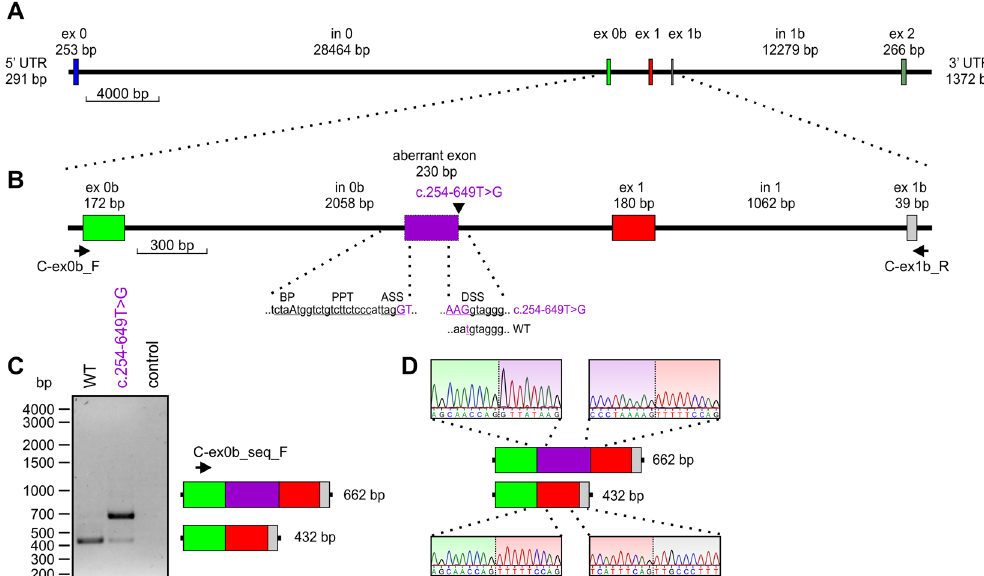
Figure 3. CLRN1 minigene splice assay. ( A ) Schematic to scale overview of the genomic CLRN1 structure including the 5 ′ and 3 ′ untranslated regions (5 ′ UTR and 3 ′ UTR, respectively). bp, basepairs. Exons (ex) are shown as colored boxes. ( B ) CLRN1 to scale minigene used for the splice experiments shown in ( C , D ). The position of the c.254–649 T > G mutation is indicated by an arrowhead and the novel exon generated by the mutation (referred to as “aberrant exon”) is displayed as a dashed purple box. The dashed lines represent a schematic magnification of the 3 ′ and 5 ′ splice sites flanking the aberrant exon. The consensus sequences for the putative branch point (BP), the polypyrimidine tract (PPT), the 3 ′ acceptor splice site (ASS), and the 5 ′ donor splice site (DSS) of the aberrant exon are underlined. The putative lariat-forming adenosine in the PPT is shown in upper case. The binding positions of the primers used for the RT-PCR shown in ( C ) are indicated by arrows. ( C ) Representative RT-PCR analysis from HEK293 cells transiently transfected with the single constructs as indicated. As control, RT-PCR from non-transfected HEK293 cells was performed. The length and exon composition of the two splice products for WT (432 bp) and the c.254–649T > G mutant (432 bp and 662 bp) are shown on the right panel. The position of the primer used for Sanger sequencing shown in ( D ) is indicated by an arrow. ( D ) Representative electropherograms of the exon-exon boundaries for both RT-PCR products of the c.254–649T > G